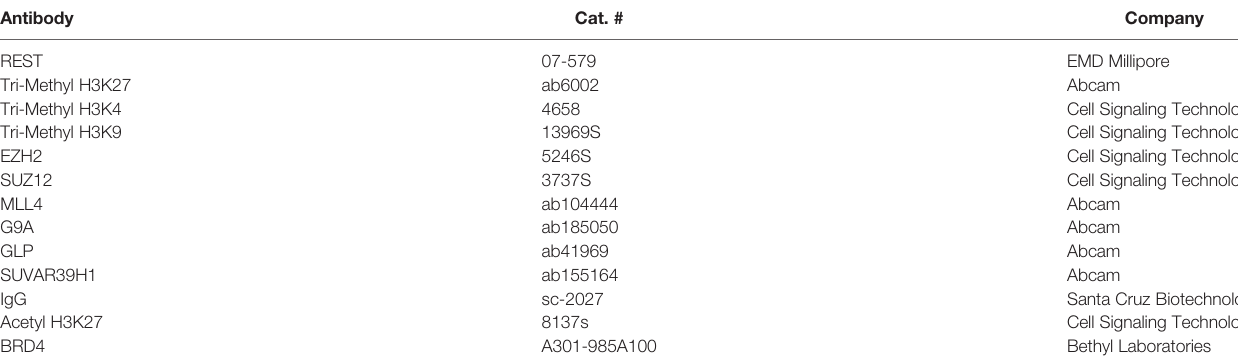
TABLE 4 | Antibodies for ChIP.